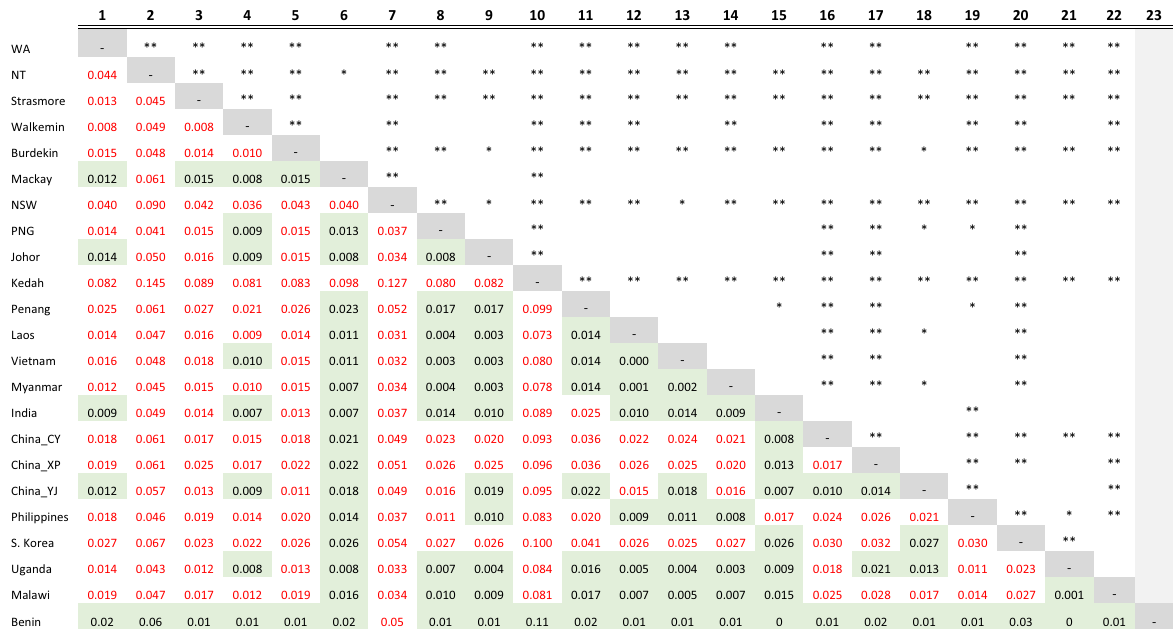
Table 1. Population genetic differentiation via pairwise F ST estimates between Spodoptera frugiperda populations from the invasive ranges of Africa (Uganda, Malawi, Benin), South Asia (India), East Asia (China (Cangyuan (CY), Xinping (XP), YuanJiang (YJ)), South Korea), Southeast Asia (Malaysia (Johor, Kedah, Penang States), Laos, Vietnam, Myanmar), and Pacific/Australia (Papua New Guinea (PNG), Australia—Kununurra (Western Australia, WA), Northern Territory (NT), Strathmore, Walkamin, Burdekin, Mackay (Queensland, Qld), Wee Waa (New South Wales, NSW). Estimates of significance are: (*) P ≤ 0.05; P ≤ 0.01 (**). Values in red are significant differentiation between pairwise comparisons, values in green cells are not significant. Western African (Benin) population (light grey column) showed non-significant pairwise F ST values with all locations except with the Malaysian Kedah State population. Refer to Table S1 and “Material and methods” section for population details and statistical calculation approach. Refer to 33 for details of African and Asian FAW